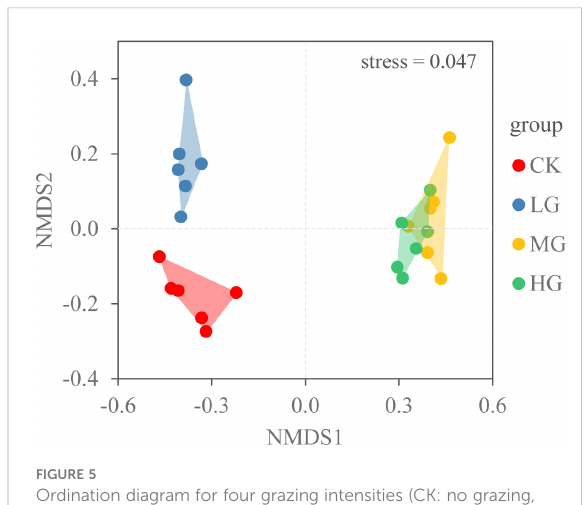
FIGURE 5 Ordination diagram for four grazing intensities (CK: no grazing, LG: light grazing, MG: moderate grazing, HG: heavy grazing) for the aboveground species density using non-metric multidimensional scaling NMDS.